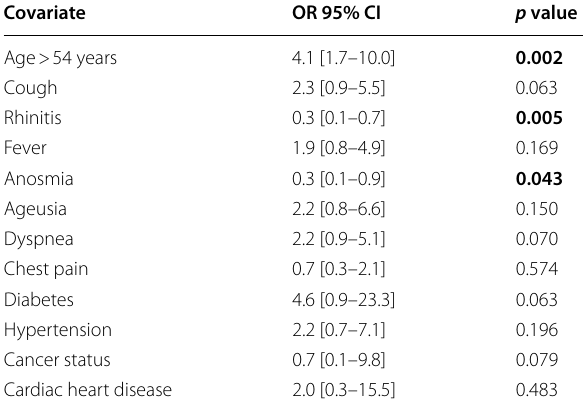
Table 4 Comorbidities and symptoms